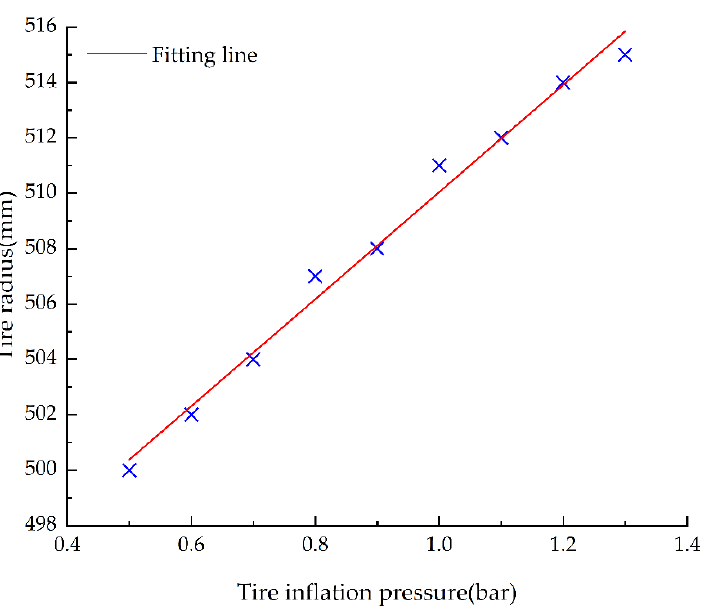
Figure 6. The relationship between tire inflation pressure and tire radius within a specific range of tire inflation pressure, a tire radius is calibrated every 0.1 bar. Then a linear model (Redline) of tire inflation pressure and tire radius is fitting.